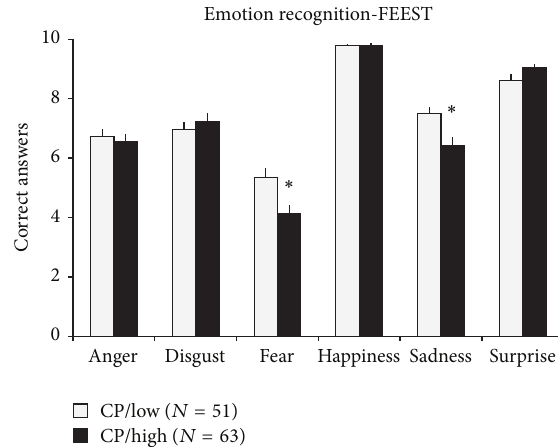
Figure 1: Results from the emotion recognition task (facial expres- sions of emotion-stimuli and tests (FEEST)) are presented. Data are expressed as mean ± SEM. CP/low: group of adolescent boys where low scores of conduct problems in the self-report version of the SDQ were present; CP/high: group of adolescent boys where high scores of conduct problems in the self-report version of the SDQ were present; ∗ : statistically significant difference ( 𝑃 < 0.05 ) from CP/low